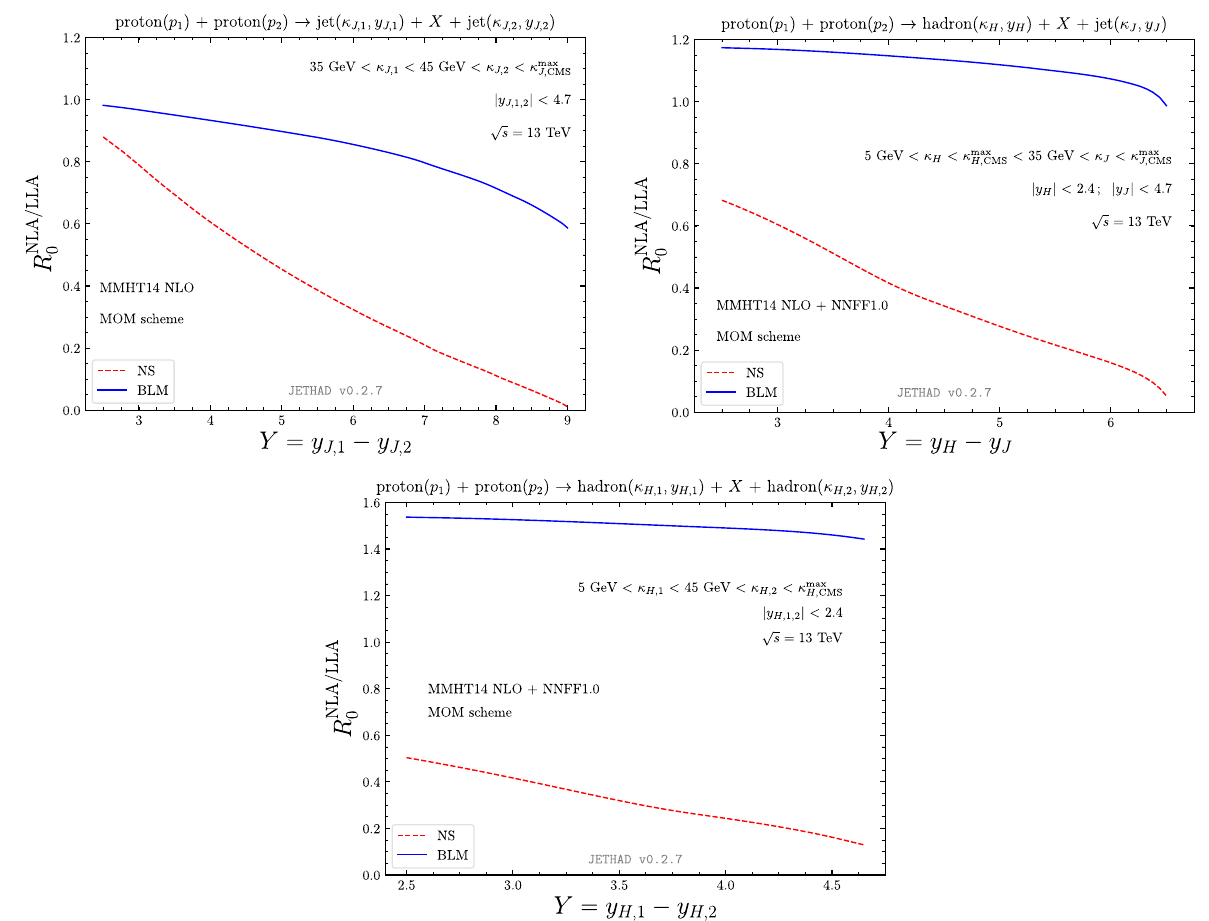
/ LLA ratio for the three considered √ 0 s = 13